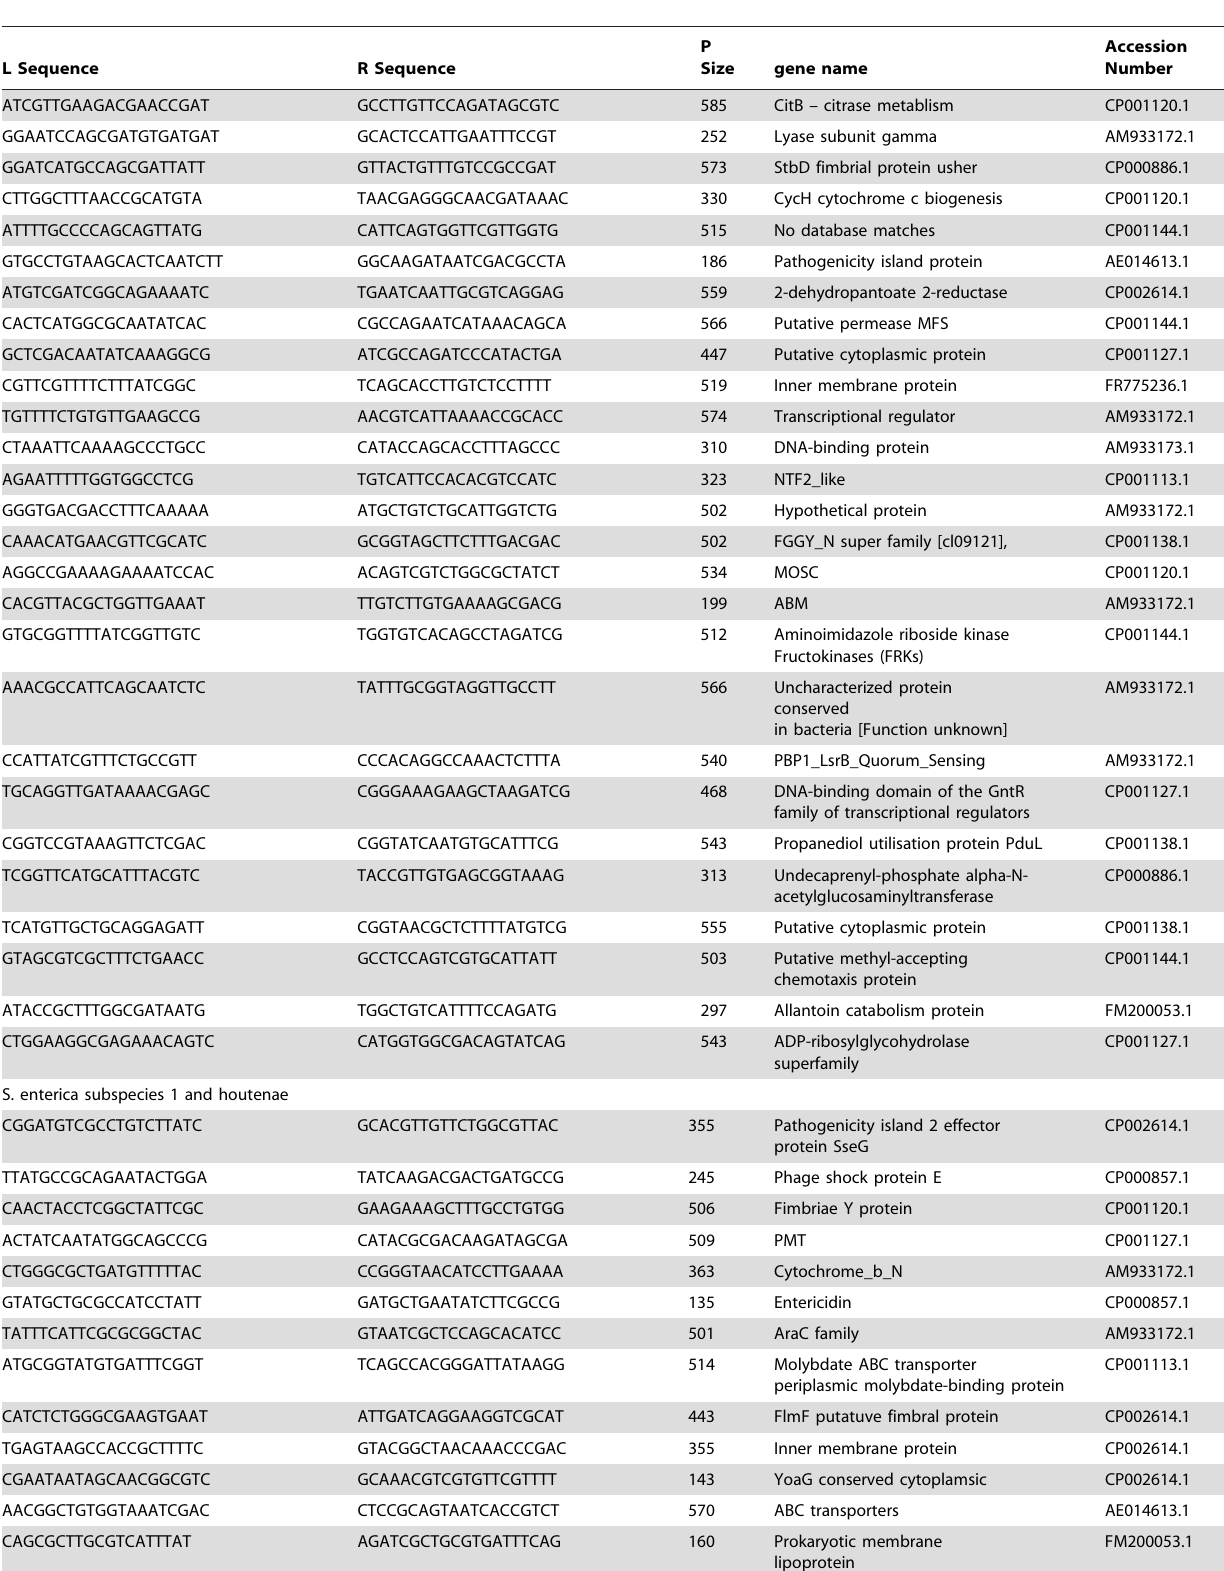
Table 3. Primers, product length, locus ID and putative function of target sequences for S. enterica .